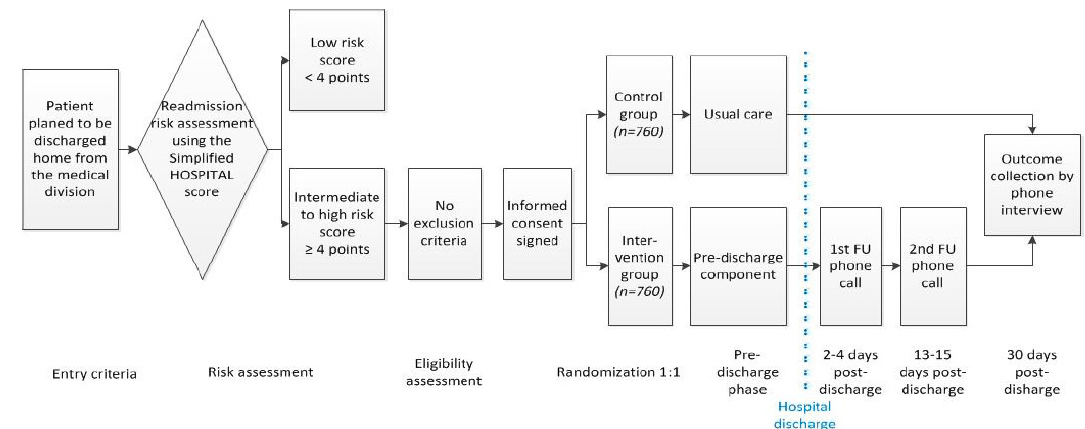
Figure 1. TARGET-READ study design.